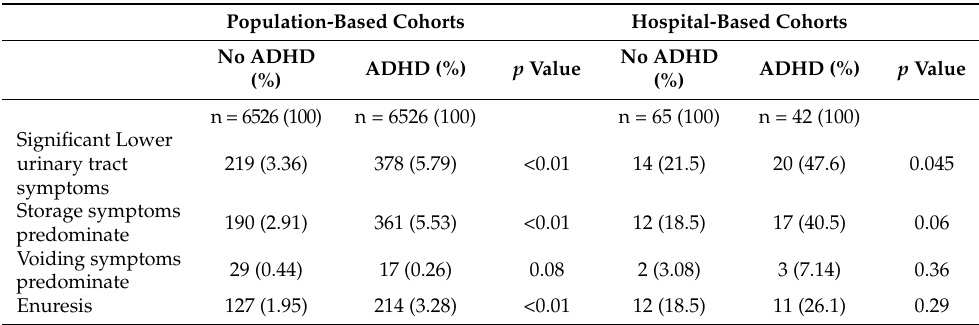
Table 3. The comparison of significant LUTS in school-age children with ADHD versus no ADHD, in population-based and hospital-based